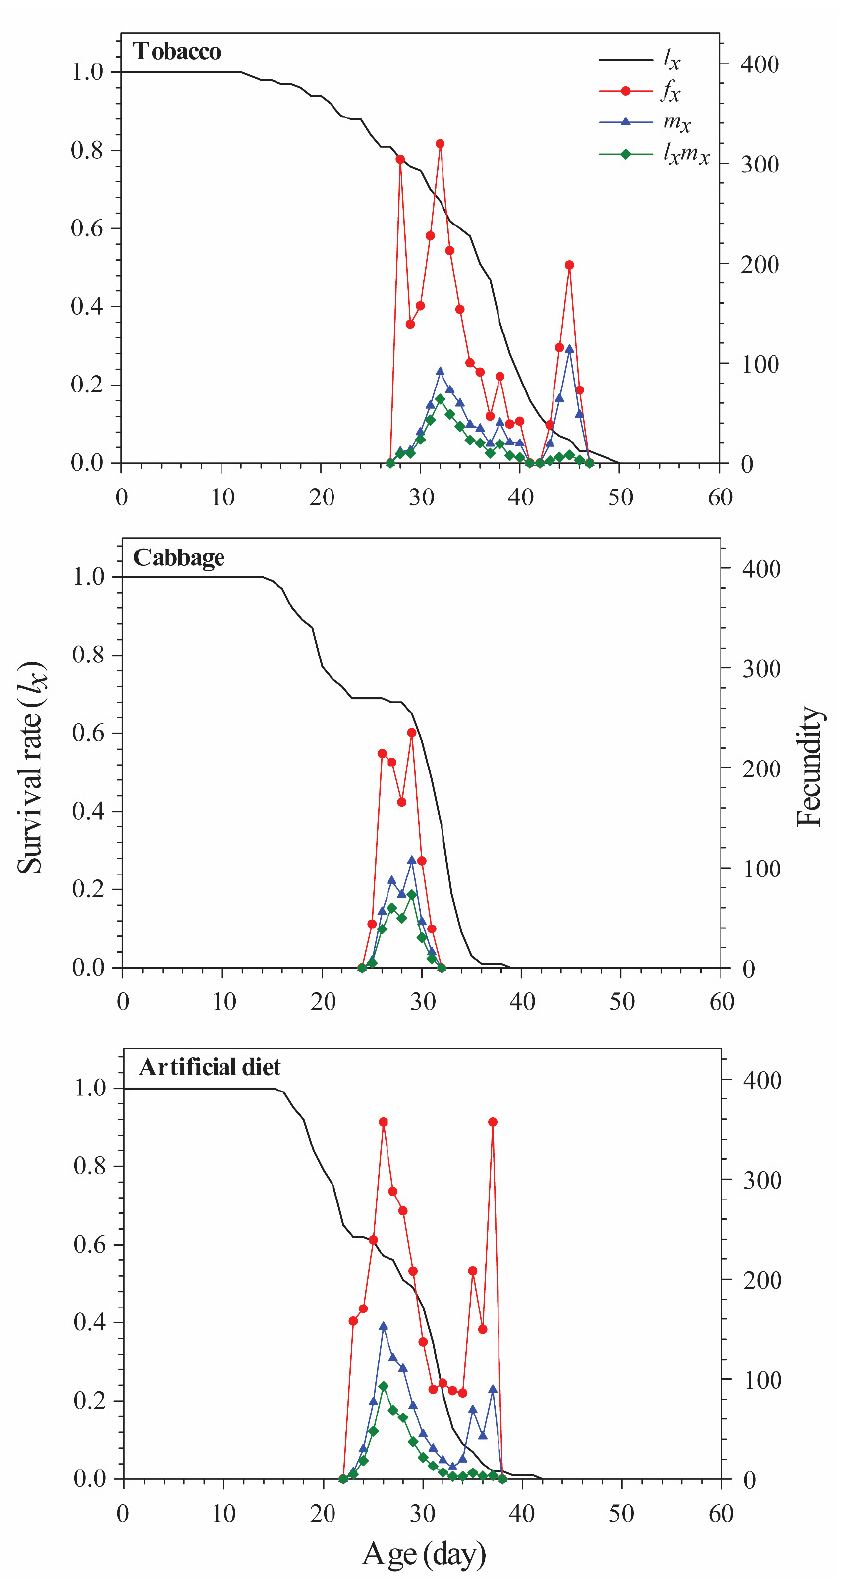
Figure 2. Age-specific survival rate ( l x ), female age-specific ( f xj ), age-specific fecundity of the total population ( m x ), and age-specific maternity ( l x m x ) of Spodoptera litura reared on different diets.